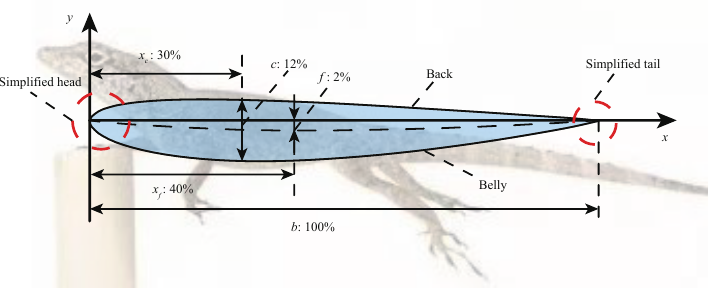
Figure 4. Equivalent cross-section model of anole lizard body.